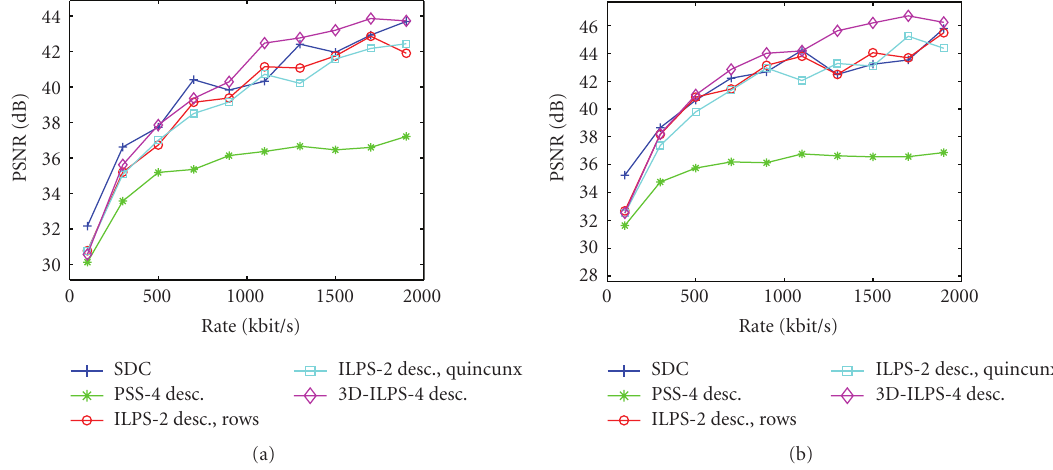
Figure 19: Performance of left view, four subsequences received, 10% packet loss. (a) Breakdance. (b)